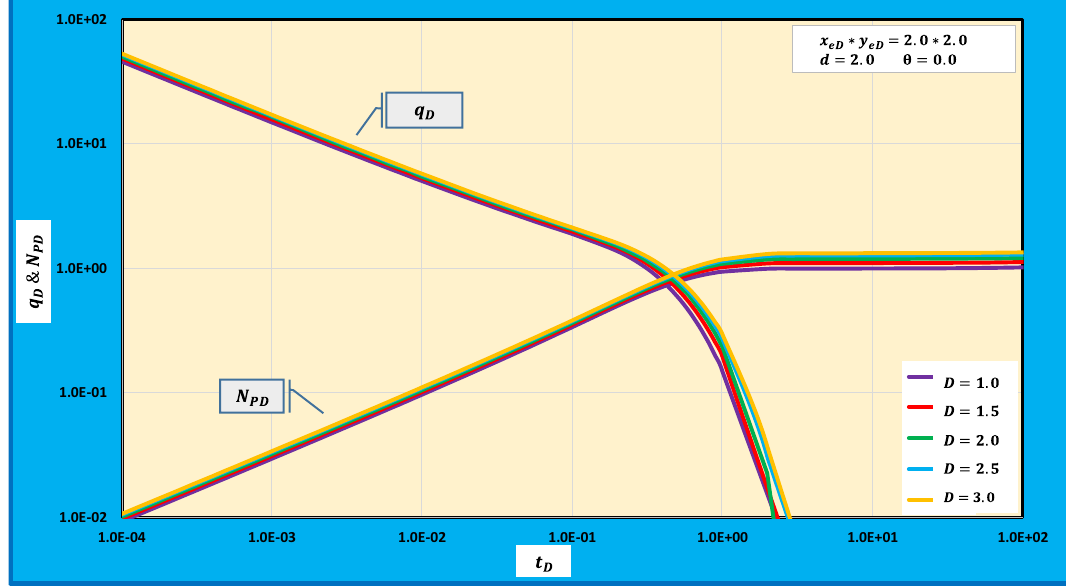
Fig. 13 Flow rate and cumulative production behaviors for different Euclidean dimensions